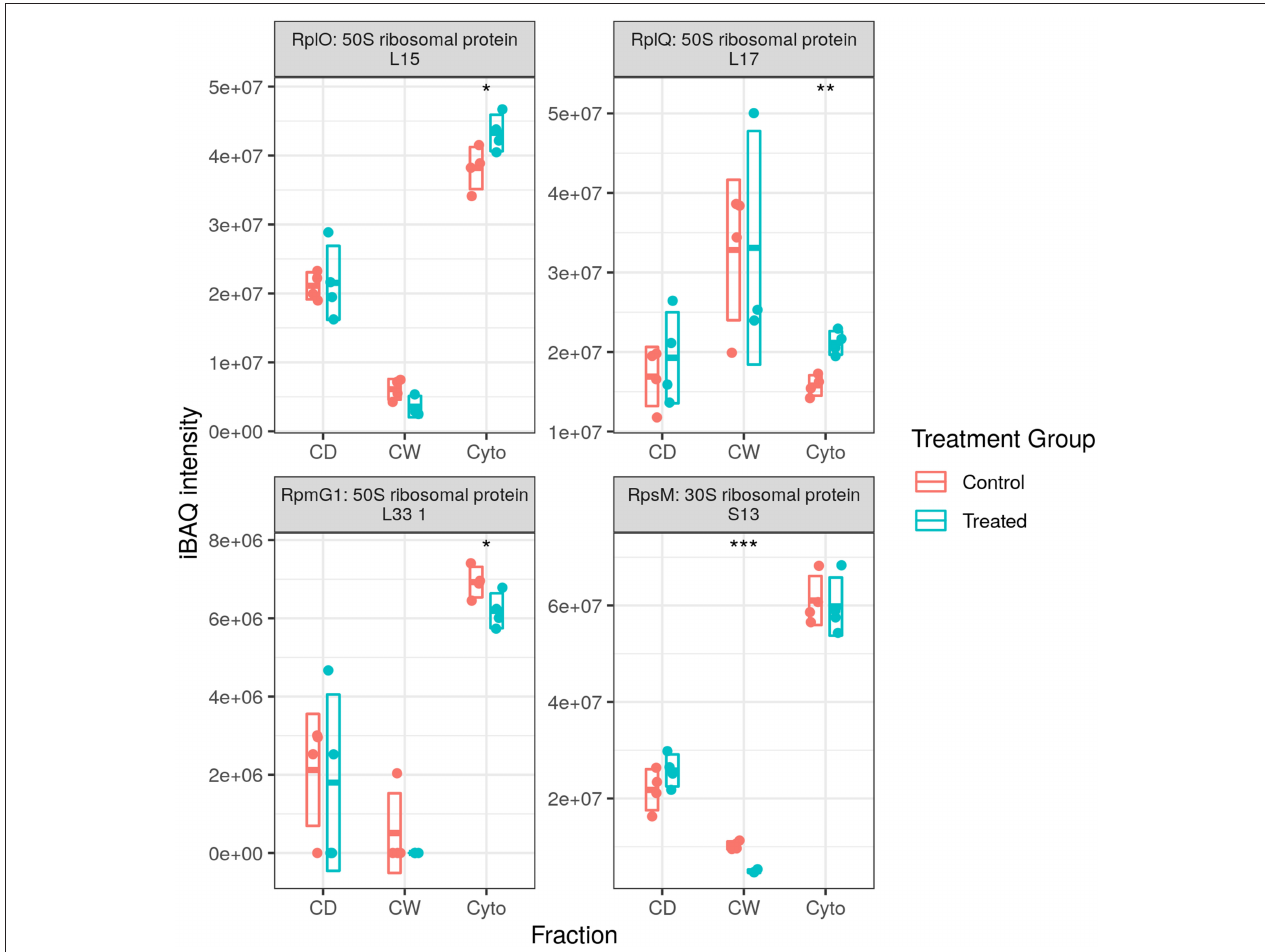
FIGURE 7 | Dysregulated proteases. Examples of protein abundance distributions for several proteases across the different fractions. Rip1 was among the most strongly upregulated proteins in both WT and SL samples. Points indicate individual replicate values and the bars indicate the mean plus/minus SD. Blue indicates control and red indicates rifampicin-treated samples. *, **, and *** indicate p < 0.05, p < 0.01, and p < 0.001